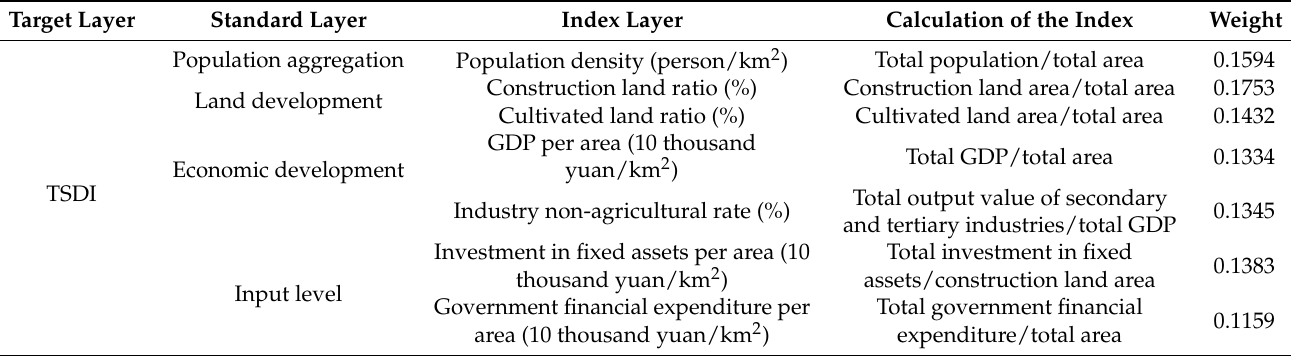
Table 1. Evaluation index system of